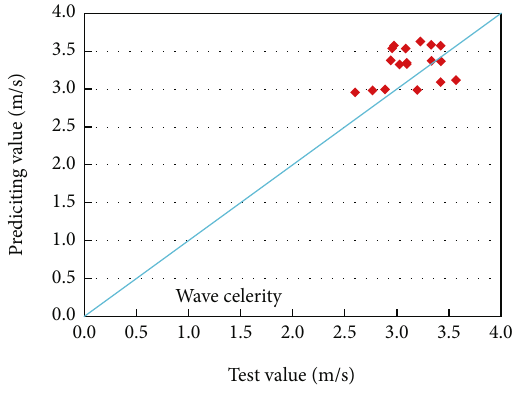
Figure 7: Calculated and experimental values of the wave celerity.